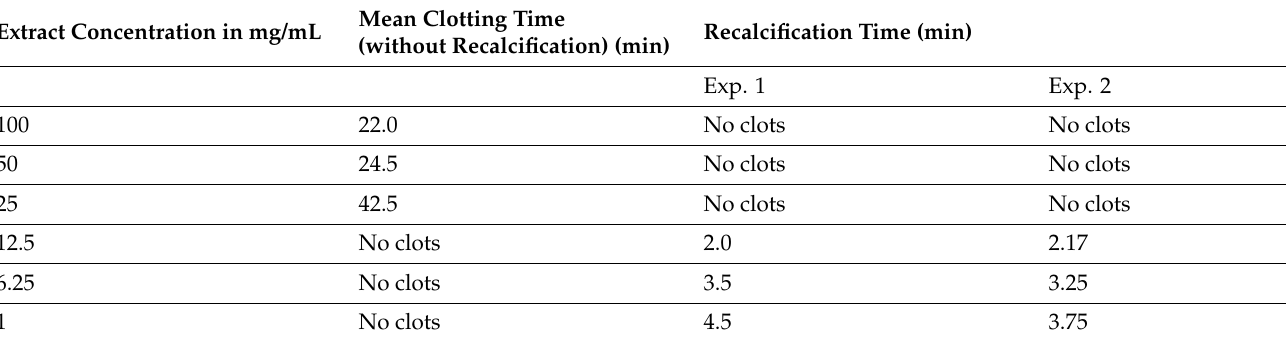
Table 5. Effect of aqueous extract of T. ciliata on coagulation time of plasma.